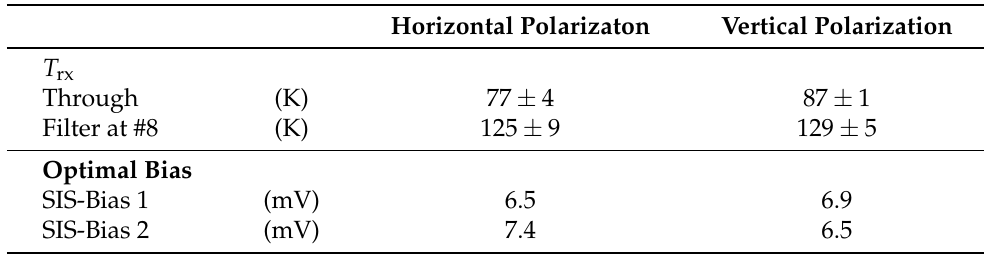
Table 2. Optimal SIS–Bias values of LSB for the lowest T rx without and with frequency separation filter.